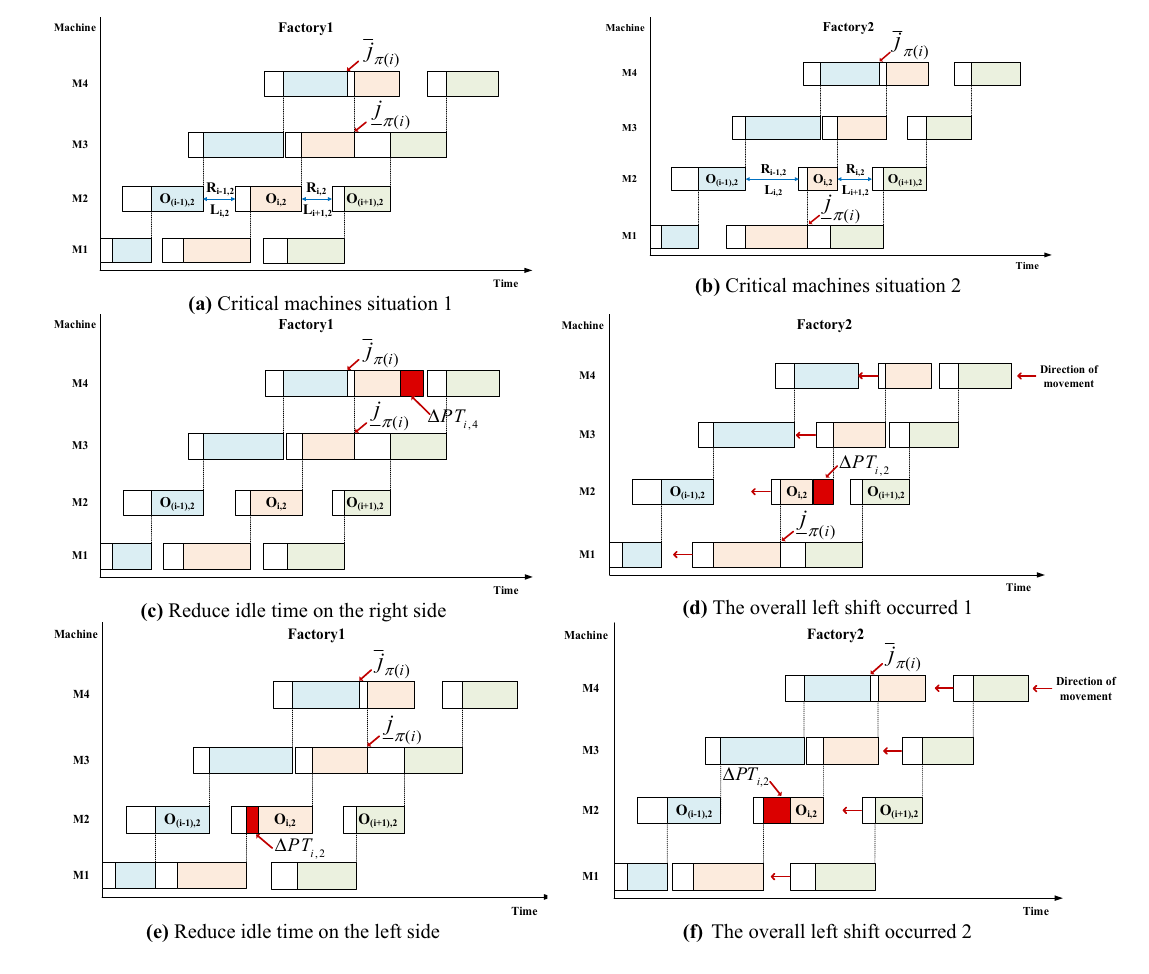
Fig. 2 Illustration of deceleration and left shift